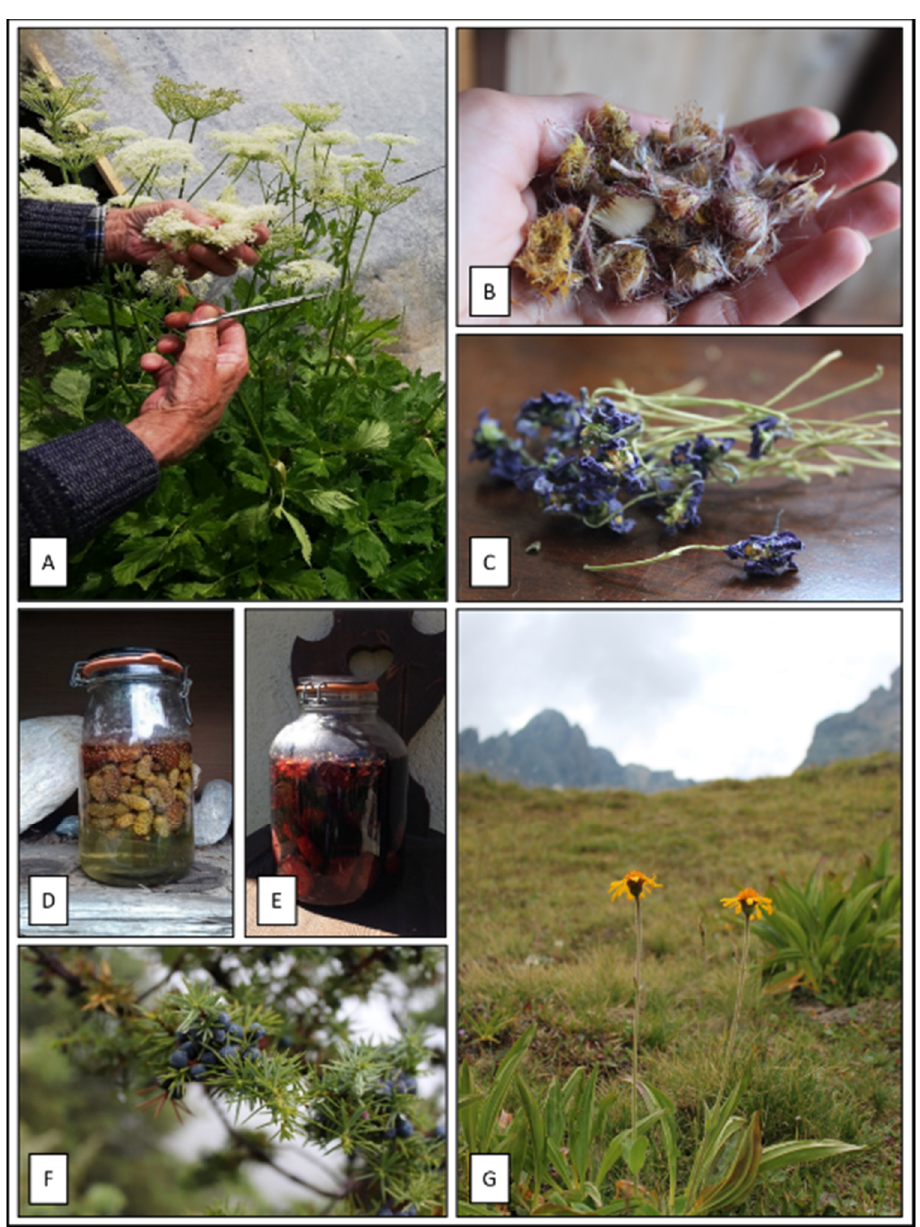
Figure 2. Medicinal plants: ( A ) Peucedanum ostruthium ; ( B ) Tussilago farfara ; ( C ) Viola calcarata ; ( D ) Pinus sylvestris syrup; ( E ) Pinus cembra syrup; ( F ) Juniperus communis ; ( G ) Arnica montana . For the respiratory tract, the species with the highest FL value (100%) were Cetraria islandica together with Tussilago farfara (91.7%) (Figure 2B) and Viola calcarata (98.3%) (Fig- ure 2C), used to treat phlegm, bronchitis and colds. Other species used for the same pur- pose are Artemisia umbelliformis , Gymnadenia nigra , Teucrium chamaedrys , Thymus pulegi- oides, Salvia officinalis and Artemisia genipi. In addition, different Pinaceae such as Pinus sylvestris L. (Figure 2D) , Pinus cembra (Figure 2E), Pinus mugo and Picea abies were widely used for the treatment of respiratory diseases: young resinous cones or buds were macer- ated with sugar in a glass jar and exposed to the sun to obtain a syrup. For the digestive system high FL value were found for Carum carvi , Gentiana punctata and Juniperus com- munis (Figure 2F) . For the diseases of the skin and subcutaneous tissues, leaves of Calen- dula officinalis , Plantago spp., Hilotelephium maximum were widely used, while latex of Chelidonium majus and Euphorbia seguieriana were indicated to treat warts. For the diseases of the genitourinary tract, Arctostaphylos uva-ursi was the most quoted plant followed by